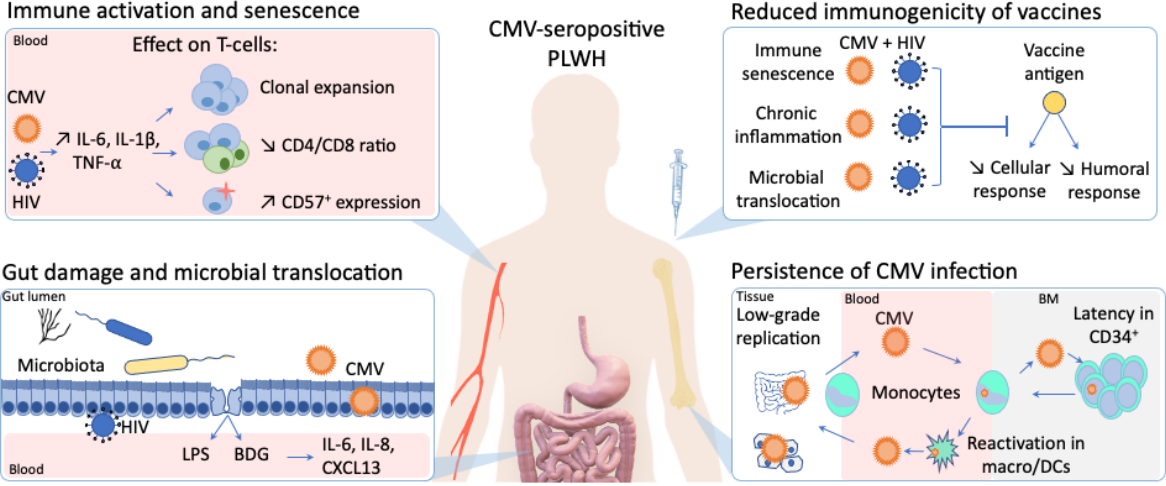
Figure 1. The influence of cytomegalovirus (CMV) persistent infection on immune activation, immunogenicity of vaccines, gut inflammation in people living with human immunodeficiency virus (HIV).